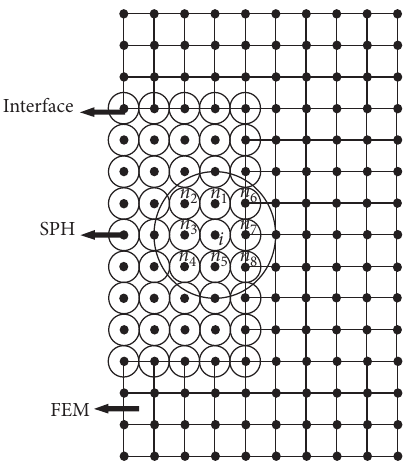
Figure 4: Contact face between SPH and FEM.